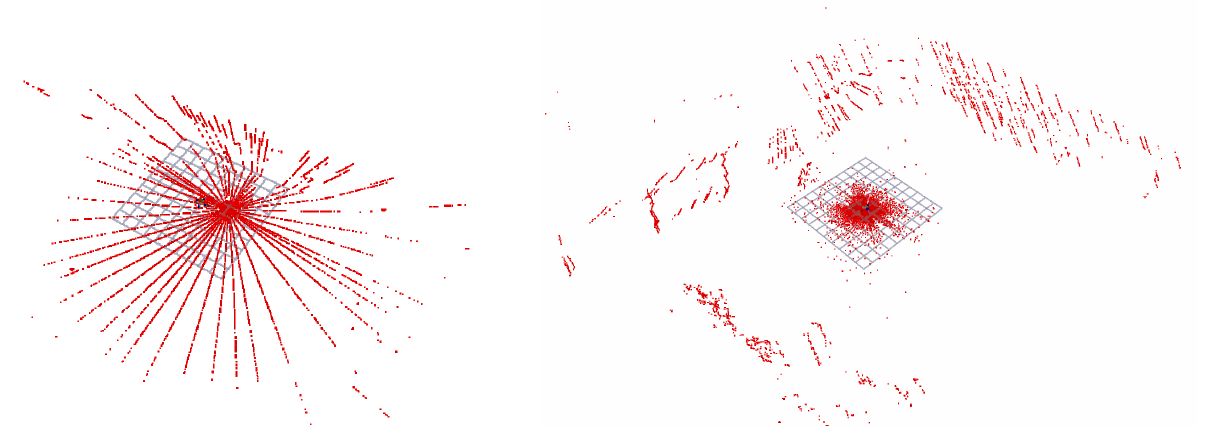
Figure 11: 3D scans acquired with our continuously rotating laser scanner in an outdoor environment during a